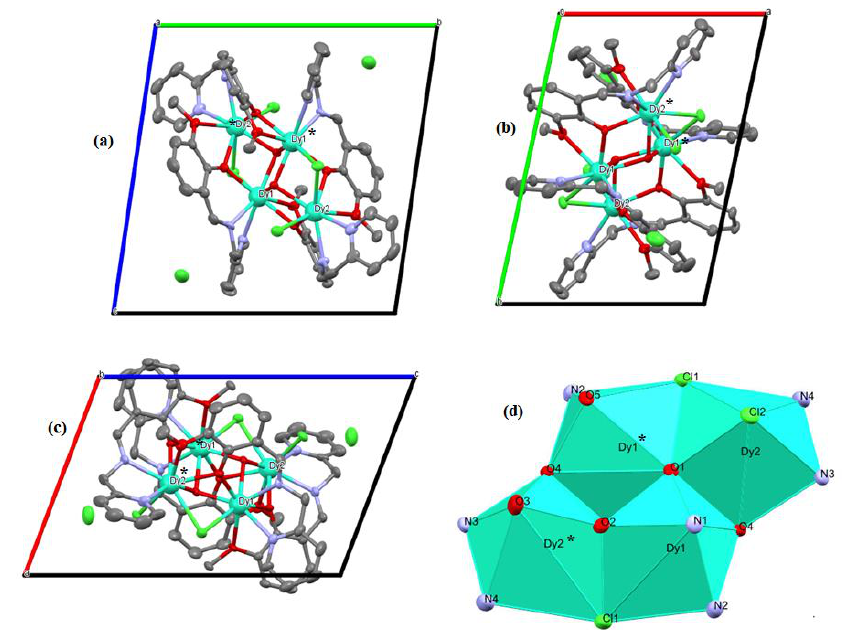
Figure 1. ( a ) Asymmetric unit of complex 1 ( b ) Full molecular structure of complex 1 ; ( c ) The dys- prosium core structure with coordinating atoms from each ligand for complex 1 ( d ) The dyspro- sium central core of complex 1 : Carbon atoms in ( c,d ) and hydrogen atoms in all the figures are omitted for clarity. Symmetry code (1-x, 1-y, -z). Color codes: cyan Dy (III), red O , black C , blue N , and green Cl and * represents symmetry generated atom.